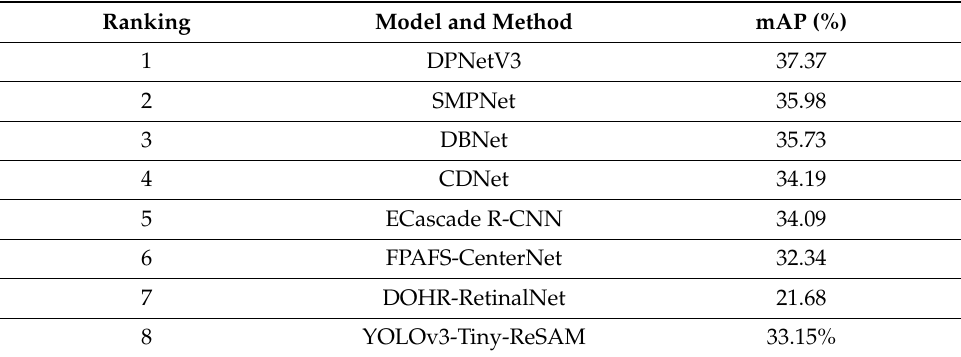
Table 2. VisionDrone2019-Challenge competition results(The first was the model that won first place in the VisionDrone2019-Challenge competition, the eighth is an improved model based on YOLOv3-Tiny).